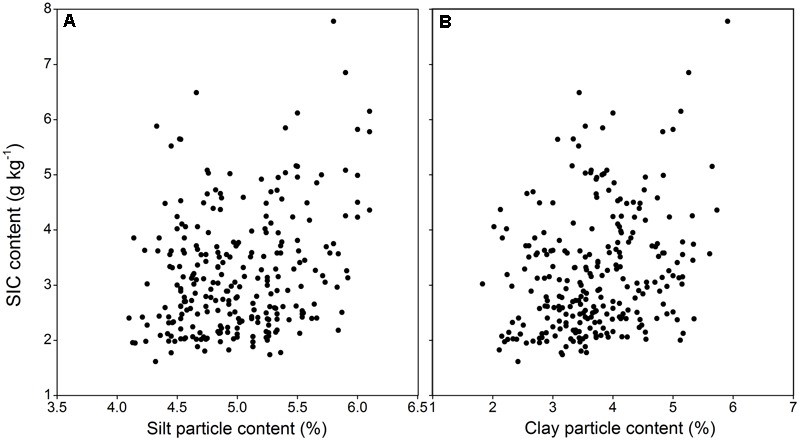
Relationships of soil inorganic δ13C value (δ13C-SIC) with silt particle content and clay particle content (using all 260 samples within 0–100 cm depth from four sample plots). (A) Relationship between δ13C-SIC and silt particle content; (B) relationship between δ13C-SIC and clay particle content. Significance of the linear regression was considered as P < 0.01.